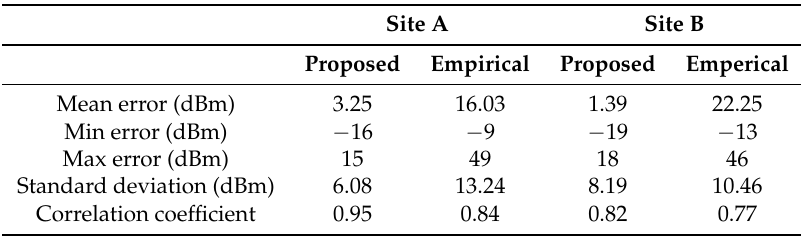
Figure 12. Comparison of Received Signal Strength Indication (RSSI) in real-time with the RSSI index estimated by the proposed system and the empirical technique of the two sites. ( a – d ) represent comparison for Access Points at LOS; Line-of-sight and NLOS; NON-line-of-sight regions for ICE and CS Departments, respectively. Sensor updates represents the correction of RSSI estimation from online feedback of corresponding sensor. Table 3. The difference error statistics in the RSSI values estimated using the proposed technique and the empirical technique against the real-time RSSI values collected at both sites. Site A (ICE Department Site), and Site B (CS Department